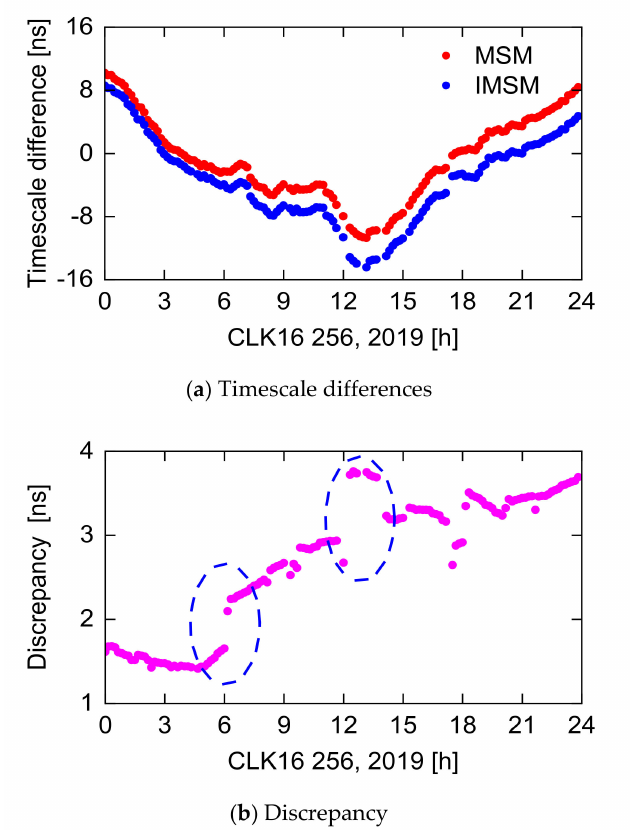
Figure 4. Timescale di ff erences ( a ) obtained by the multi-satellite method (MSM) and the improved multi-satellite method (IMSM), and their discrepancies ( b ) on day of year 256, 2019. Real-time clock product CLK16 is used to compute the timescale di ff erence with respect to the referenced Deutsches GeoForschungsZentrum (GFZ) multi-GNSS experiment (MGEX) post-processed clock